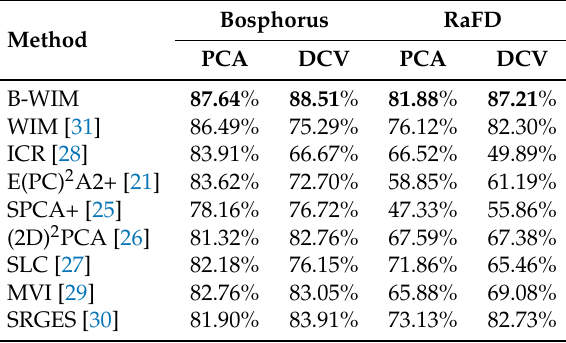
Table 4. Face recognition results in Open Set